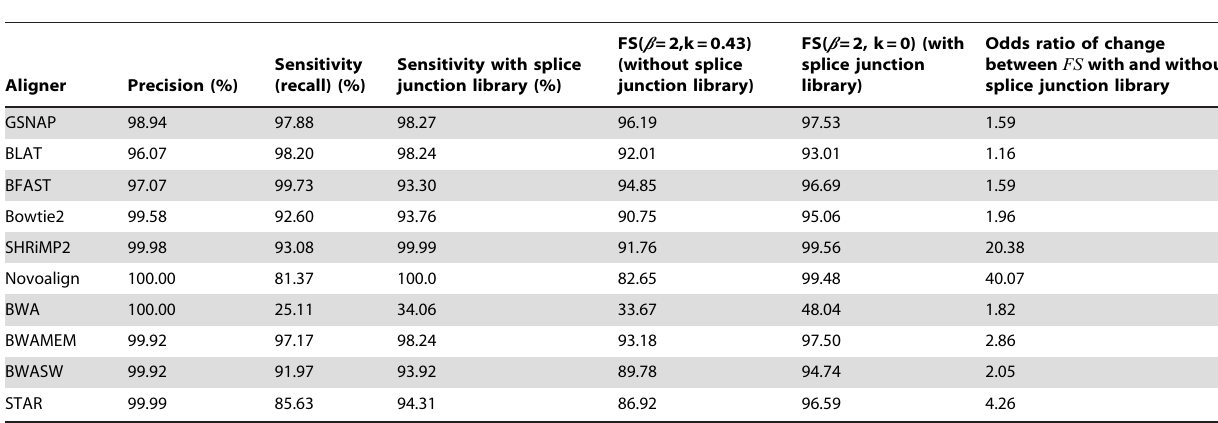
Table 8. Precision, sensitivity and the FS score for reads simulated from the human reference sequence.